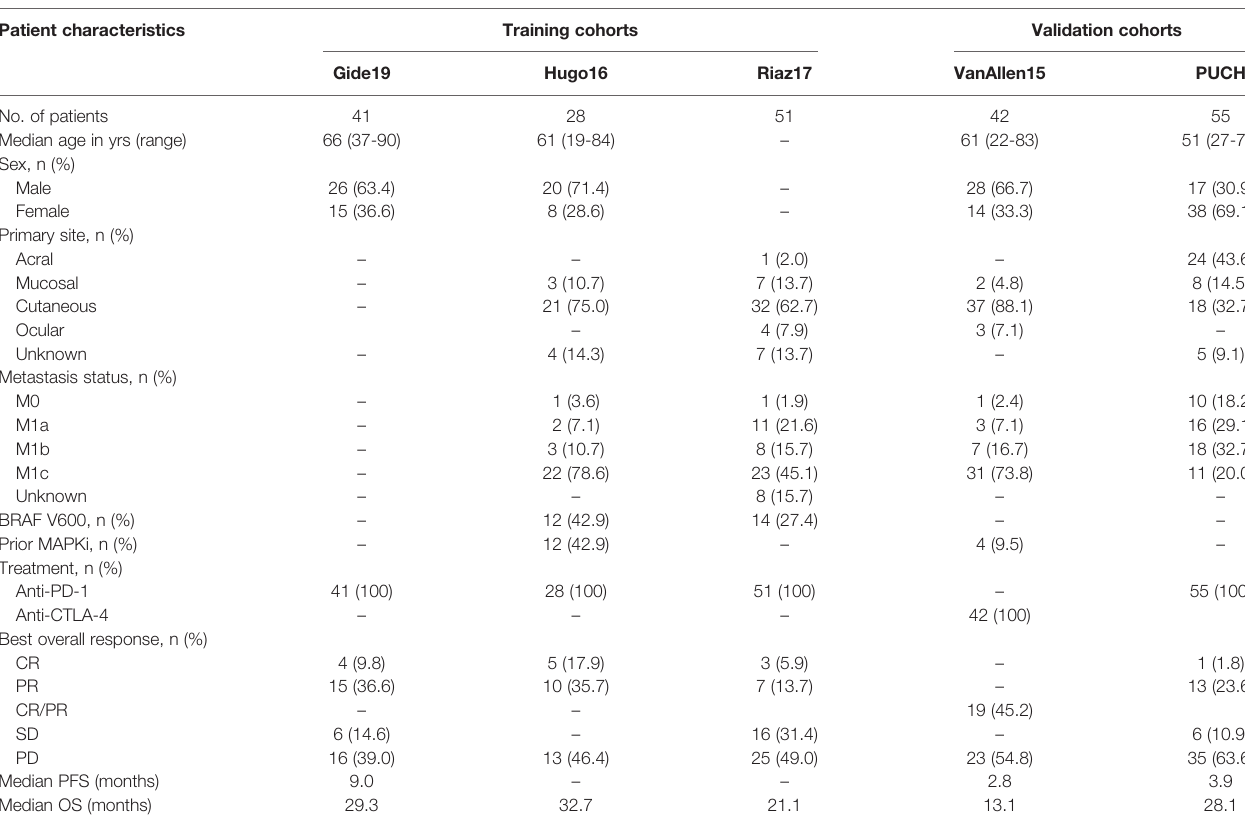
TABLE 1 | Clinicopathological characteristics of fi ve immunotherapy cohorts included in this